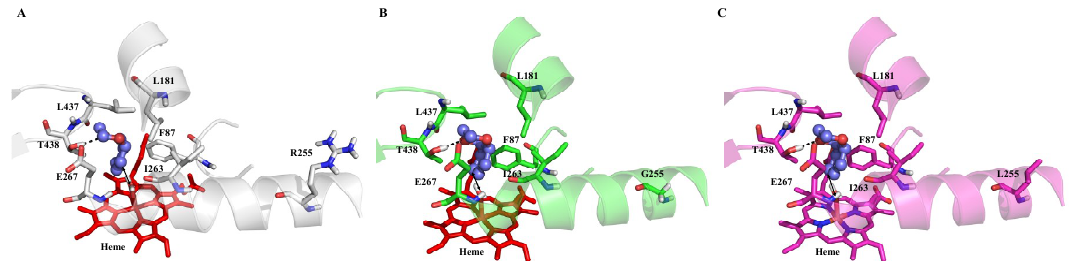
Figure 8. Molecular docking pose of benzo-1,4-dioxane in the active site of WT, R255G, and R255L ( A ) WT (binding energy: − 5.63 kcal / mol), ( B ) R255G variant (binding energy: − 5.66 kcal / mol), and ( C ) R255L variant (binding energy: − 5.66 kcal / mol). Reciprocal arrows indicate the closest distance between the iron-bound water ligand and C5 atom of benzo-1,4-dioxane (WT: 5.14 Å, R255G and R255L: 4.90 Å). Substrate benzo-1,4-dioxane is depicted as a ball and stick, whereas all the active site residues including heme are depicted as sticks. Hydrogen bond between substrate and T438 is represented as a black dotted line.